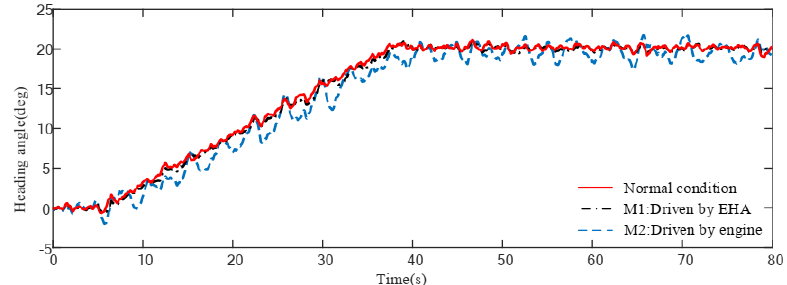
Figure 15. Heading angle response for damage scenario I under uncertainties and turbulences.